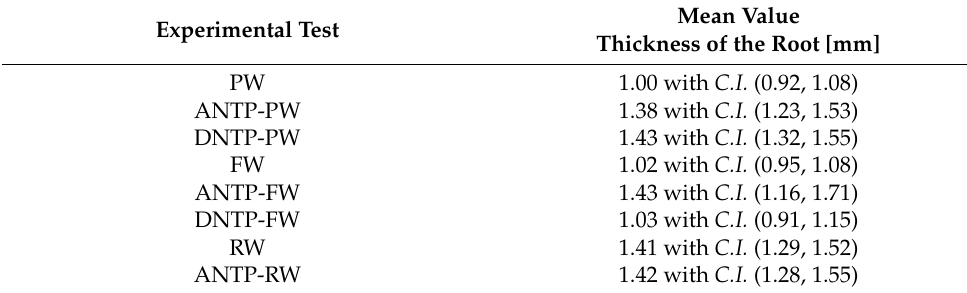
Table 2. The thickness of the root of lentil plants in experimental